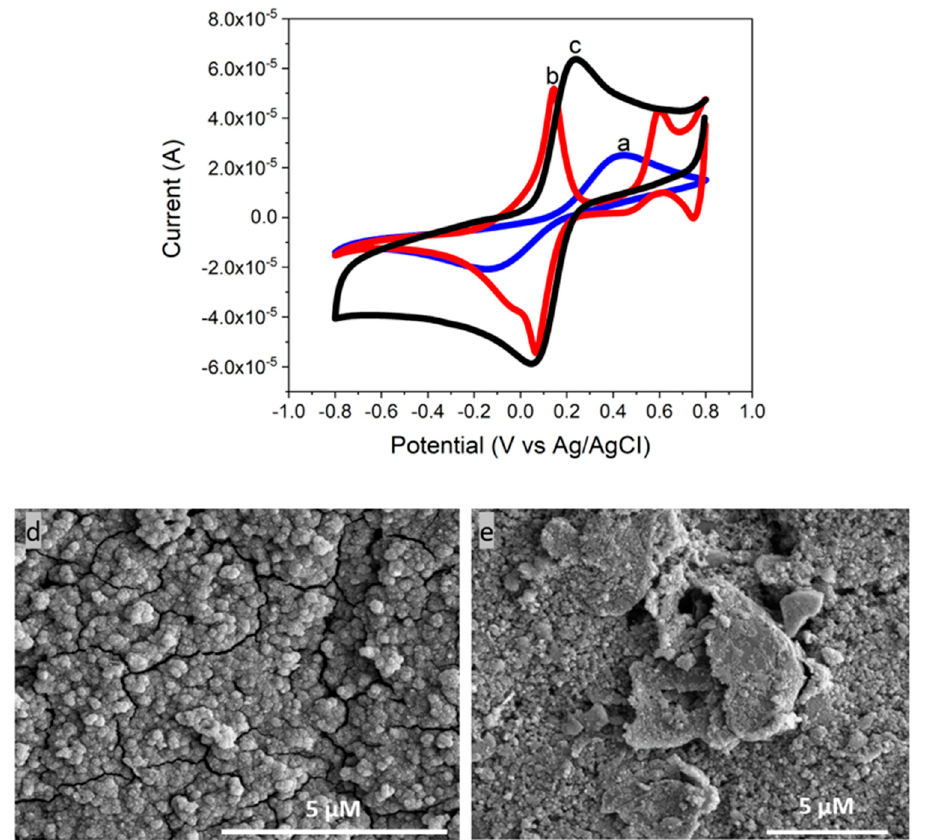
Figure 5. CV responses of ( a ) a bare screen printed carbon electrode (GCE), ( b ) PB deposited on a GCE, and ( c ) CeNP / GO / PB modified GCE in a 0.1 M phosphate bu ff er solution (PBS), pH 7.2 containing 5 mM of [Fe(CN) 6 ] 3 − / 4 − and 0.1 M KCl with 100 mV / s of scan rate. SEM images of ( d ) PB deposited on a GCE and ( e ) CeNP / GO / PB modified GCE.